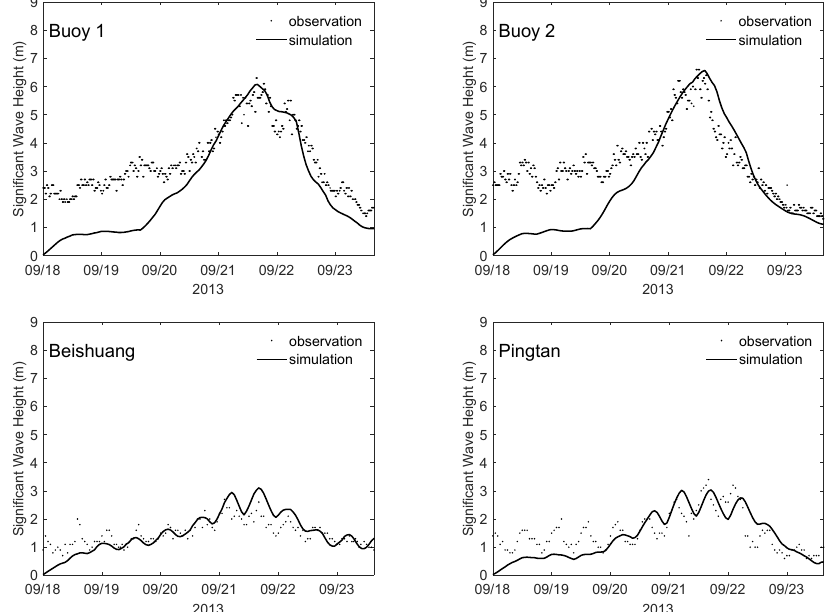
Figure 5. Comparison of significant wave height simulations and observations along the Fujian coast during Typhoon Usagi .